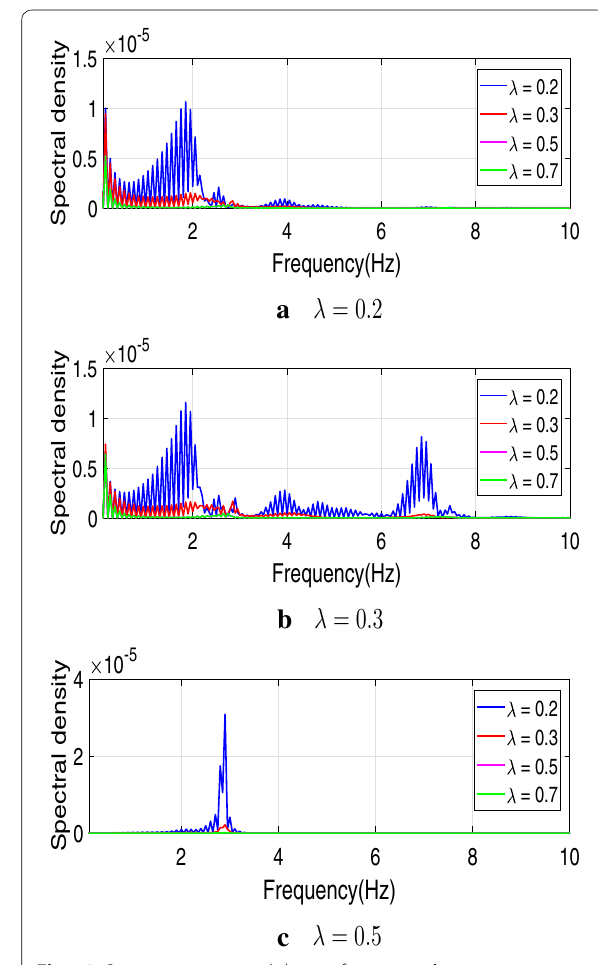
Fig. 18 Strain power spectral density for varying